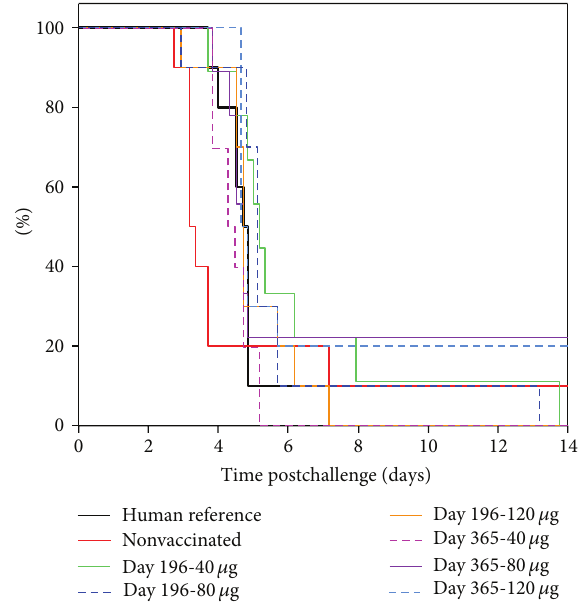
Figure 2: Combined survival plots of 3 studies following passive therapy of mice with either nonimmune or plague vaccinated volunteer serum. Study (1), 𝑛 = 6 per group, study (2), 𝑛 = 10 per group, and study (3), 𝑛 = 10 per group. Mice were administered 250 𝜇 L human serum into the peritoneal cavity, 3 hours before being exposed to more than 10 LD 50 aerosolised Y. pestis using a modified contained Henderson apparatus. The median time to death (MTD) was calculated using a Kaplan-Meier survival plot.